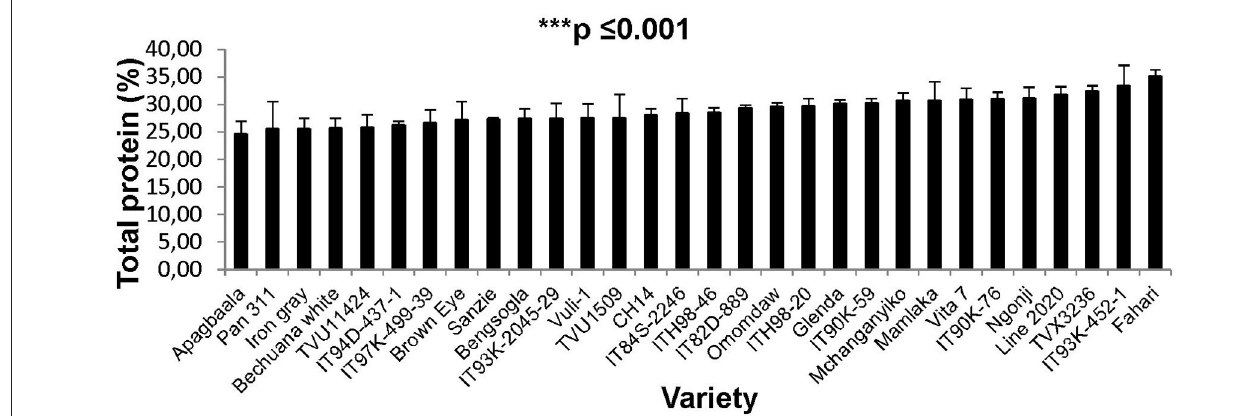
FIGURE 3 | Total leaf protein in cowpea varieties at Manga, 2005.